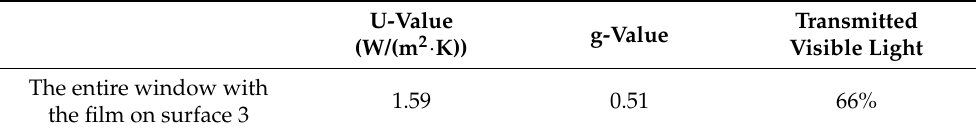
Table 4. The entire window with low E-film; technical data measured in a field t est in 2018 by Mattsson et al. [33].